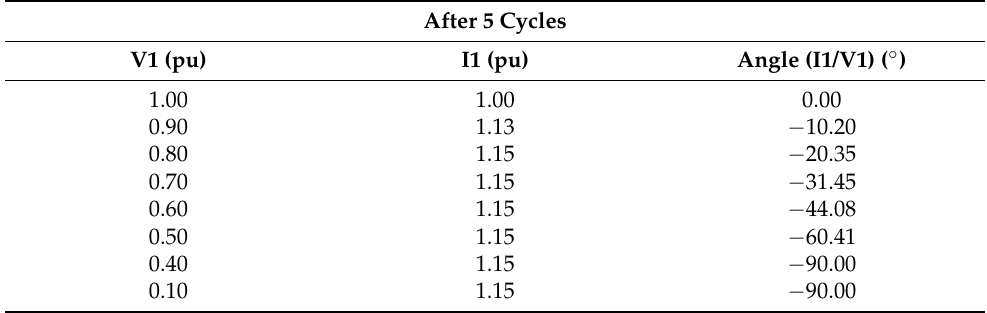
Table 1. Fault current contribution of an example Type IV-based IBR as a function of terminal